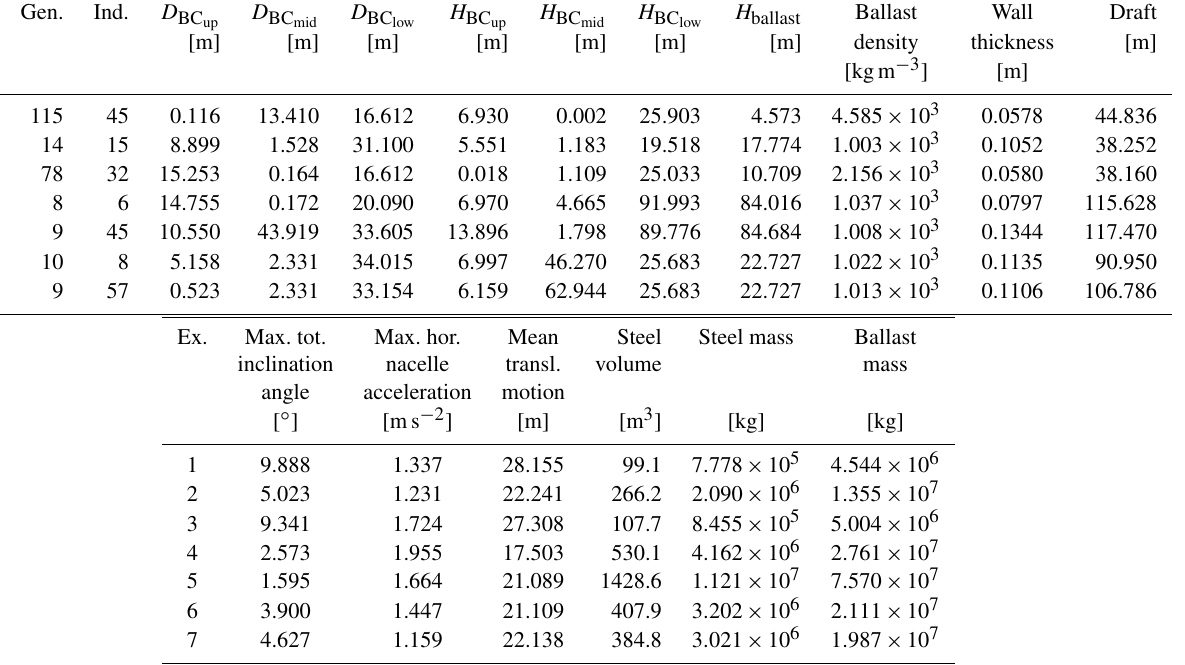
Table 7. Key figures of the exemplary potential innovative floater geometries. Ex.